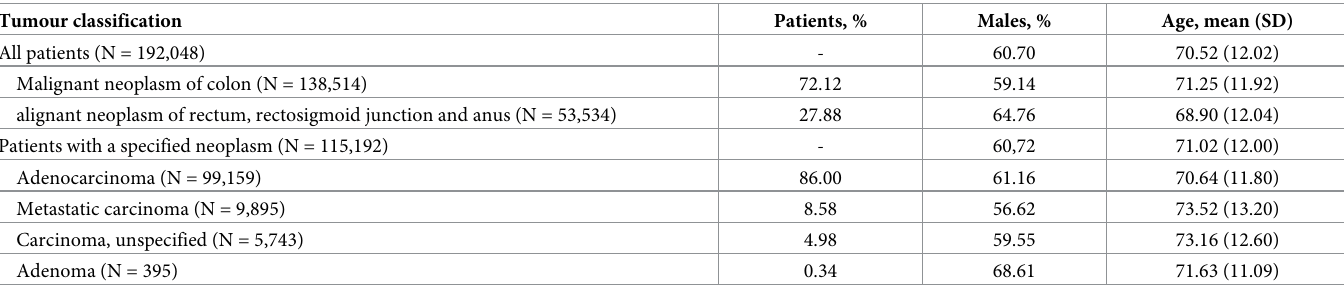
Table 2. Percentage and characteristics of patients diagnosed with malignant neoplasms of colon, rectum or neuroendocrine colorectal tumours. Tumour classification Patients,